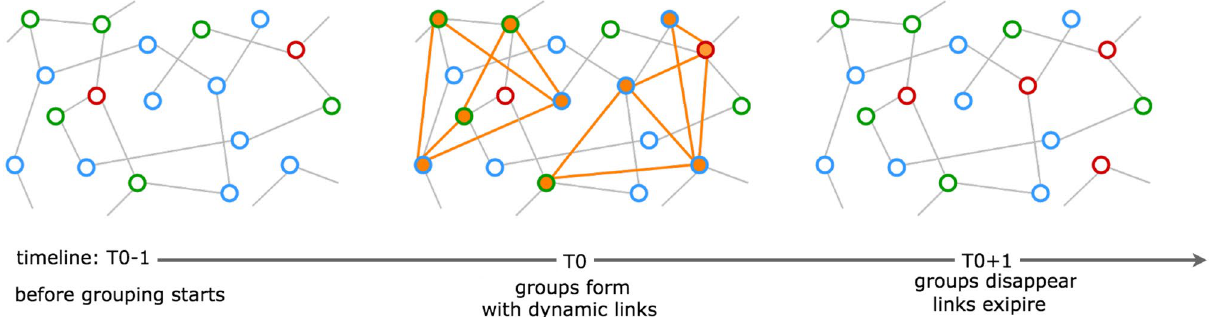
Figure 1. The contact network is described through static links and agent states. Red is for Infected (e.g., spreading agents, infected individuals in disease epidemics, adopters in product adoption, spreaders in opinion diffusion), green is for Recovered (e.g., agents no longer spreading, immunized, stifler, contrarian, antagonist, deluded are possible definitions in different contexts), and blue is for Susceptible (e.g., agents possibly becoming spreading actors, ignorant, undecided, laggard); filled in orange are agents belonging to an ephemeral Fig. 1, the two red agents (Infected, for simplicity) are no longer spreading because connected only to green agents (Recovered). In the bottom right corner, a blue agent (Susceptible) appears as disconnected from the visible portion of network.